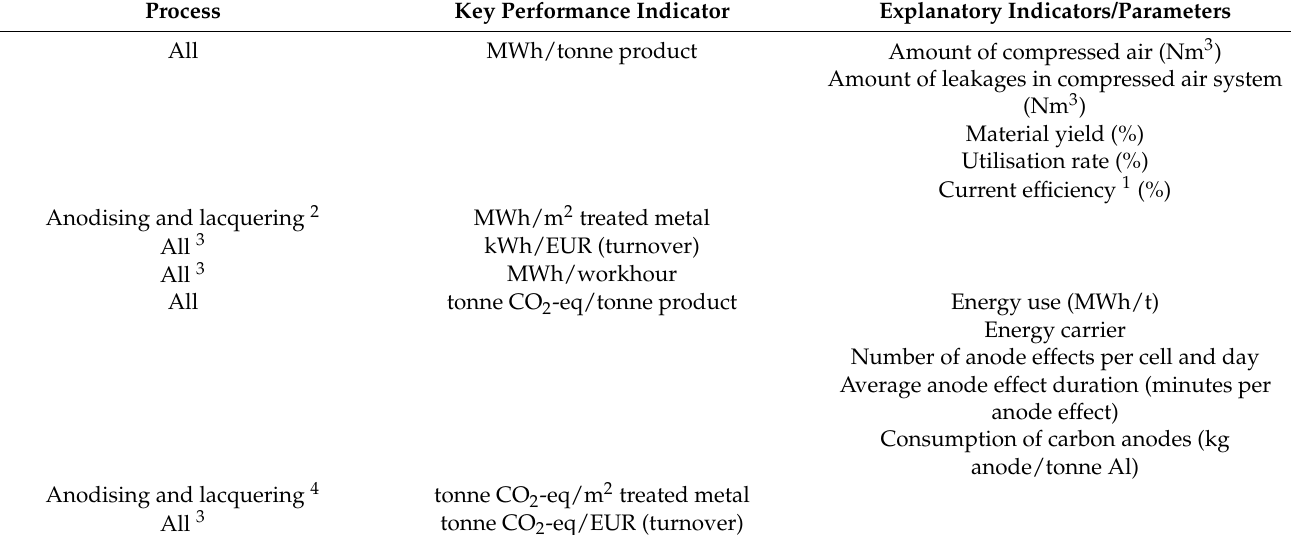
Table 3. Key performance indicators proposed by the respondents in the Swedish aluminium industry and one aluminium casting foundry. Key Performance